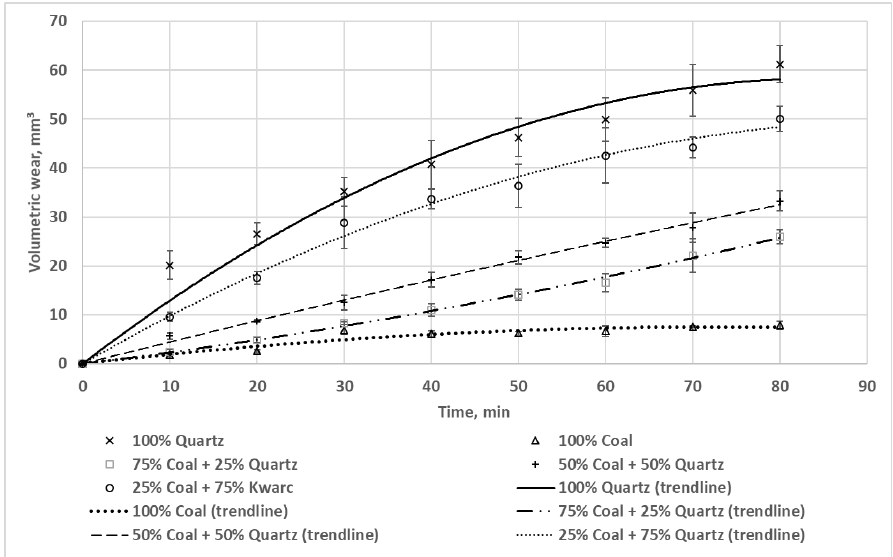
Figure 15. Time processes of volumetric wear u V of WRS_400_II steel for the discussed wear vari- ants.